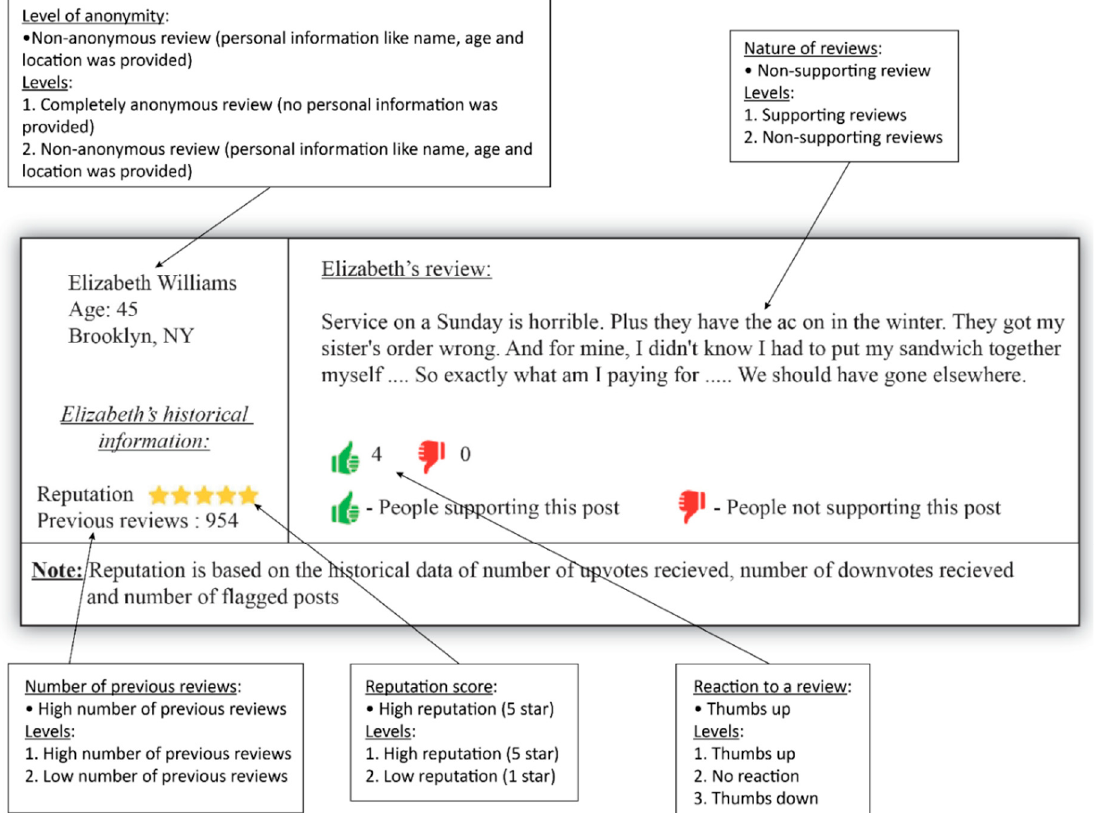
Figure 2. Non-anonymous and non-supporting review of a restaurant with thumbs up, high reputation and high number of previous reviews.